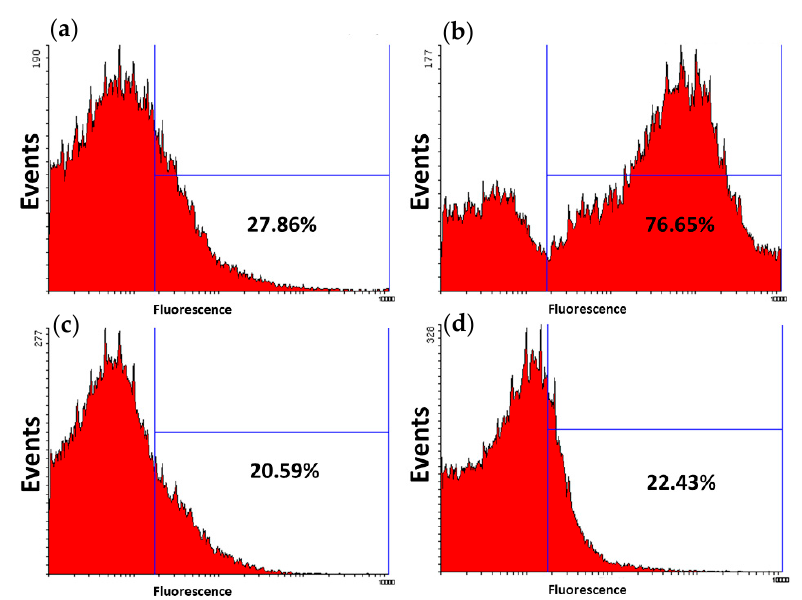
Figure 6. Fluorescence histograms of nucleocapsid-like particles in flow cytometry analysis. ( a ) Fluorescence distribution of the particles formed by p116 alone; ( b ) fluorescence distribution of particles formed by p116 with fluorescent-labeled tRNA; ( c ) fluorescence distribution of the particles formed by p73 alone; ( d ) fluorescence distribution of particles formed by p73 mixed with labeled tRNA.